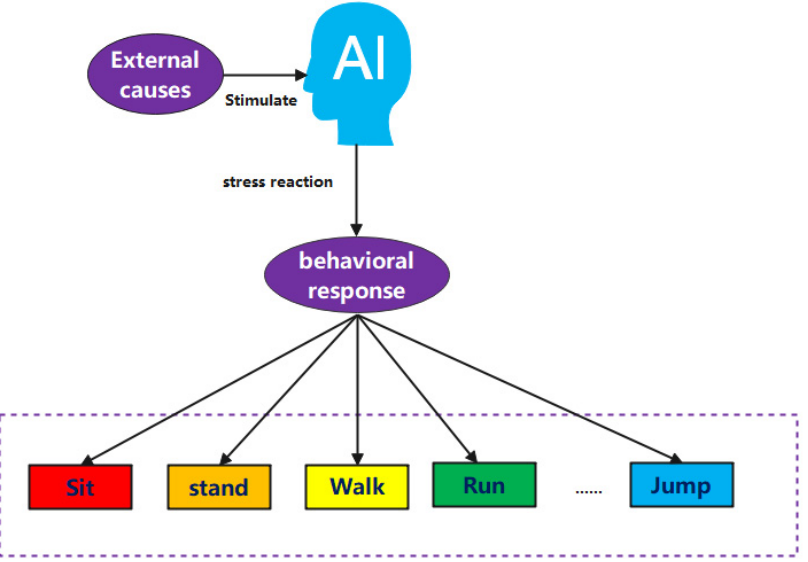
Figure 1. The principles behind human behavior.